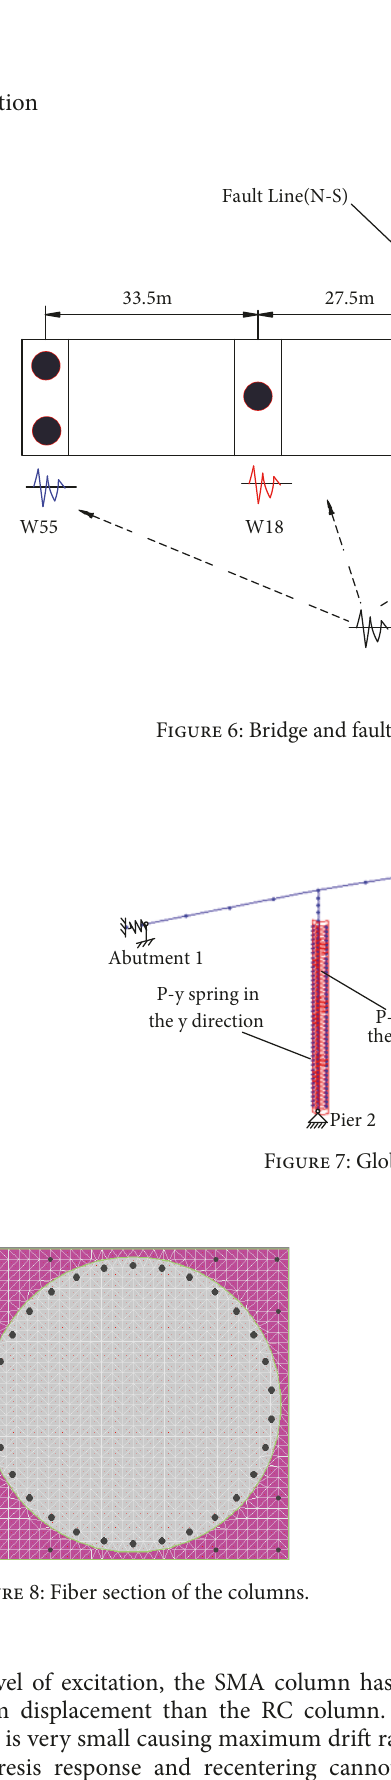
bigger maximum displacement than the RC column. The of 1.88%. Hysteresis response and recentering cannot be judged based on such a small motions. So the amplitude of each motion is double scaled to produce a bigger peak